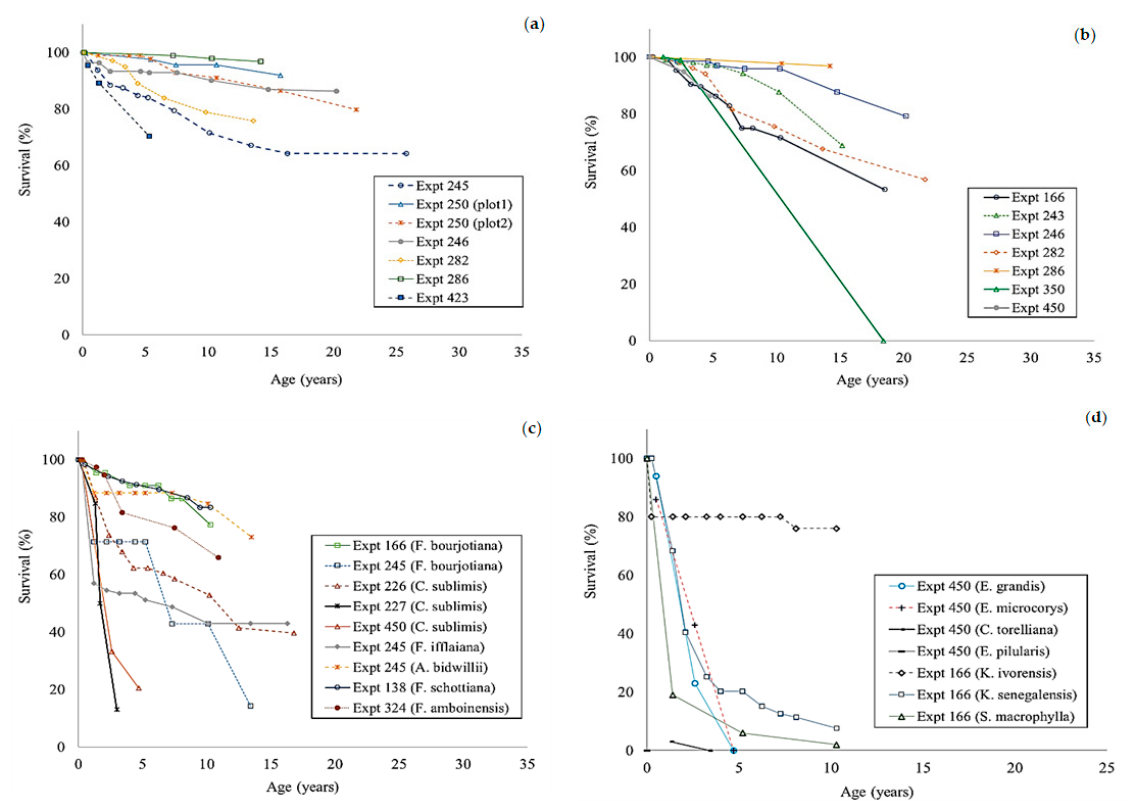
Figure 2. The survival of Agathis robusta ( a ); Araucaria cunninghamii ( b ); Cardwellia sublimis, Araucaria bidwillii, Swietenia macrophylla, Flindersia bourjotiana, Flindersia schottiana, Flindersia i ffl aiana, and Flindersia amboinensis ( c ); Khaya ivorensis, Khaya senegalensis, Eucalyptus grandis, Eucalyptus microcorys, Corymbia torelliana, and Eucalyptus pilularis ( d ) in enrichment planting experiments in north Queensland. Plot 1 of experiment 250 was planted with the southern provenance of Agathis